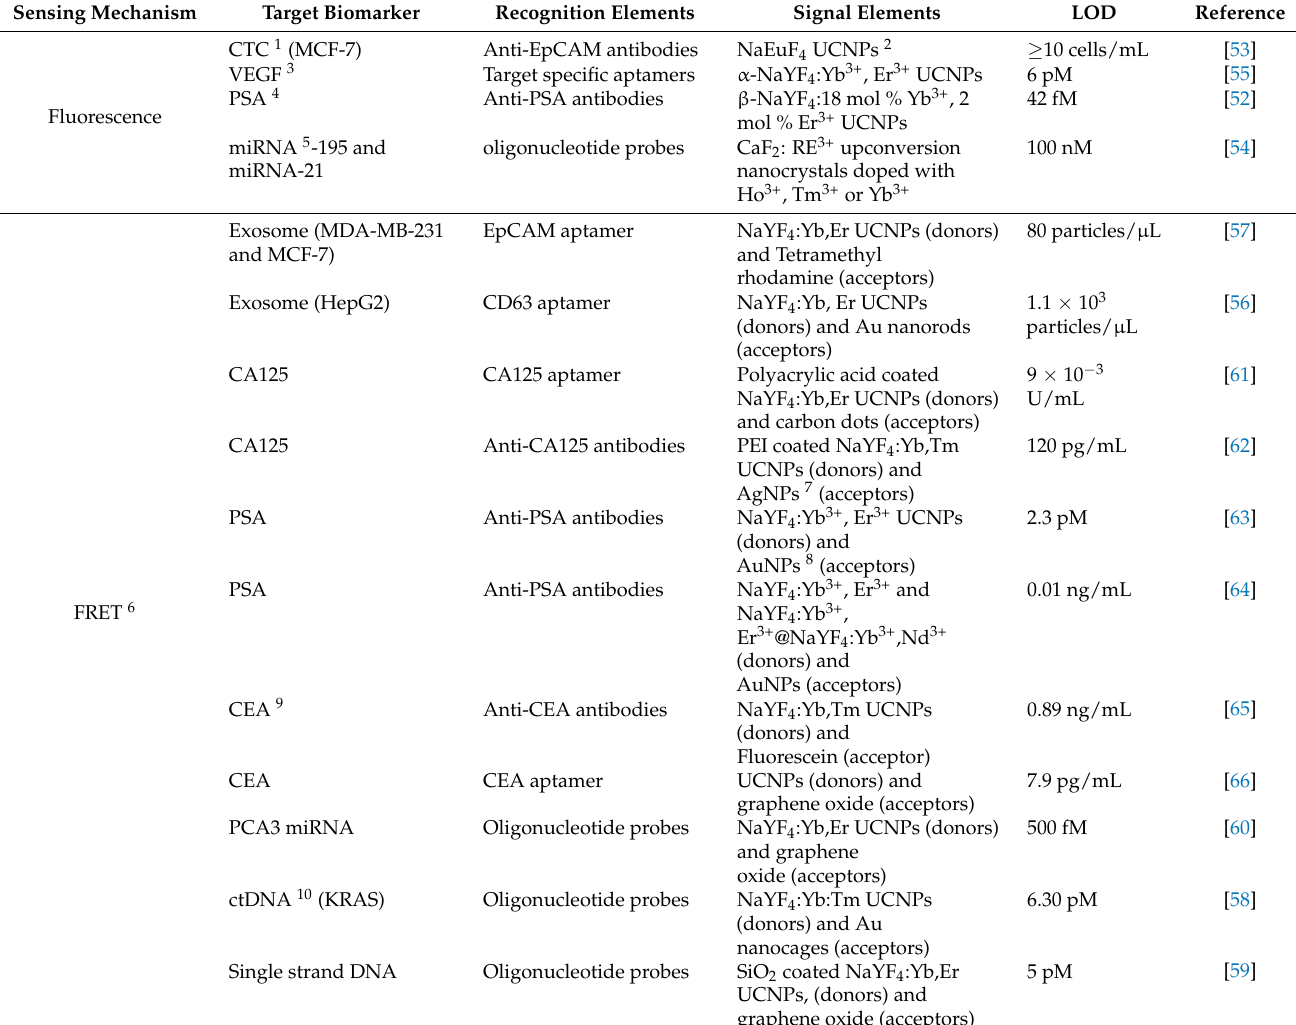
Table 3. Upconversion nanoparticle-based optical biosensors for circulating cancer biomarkers. Sensing